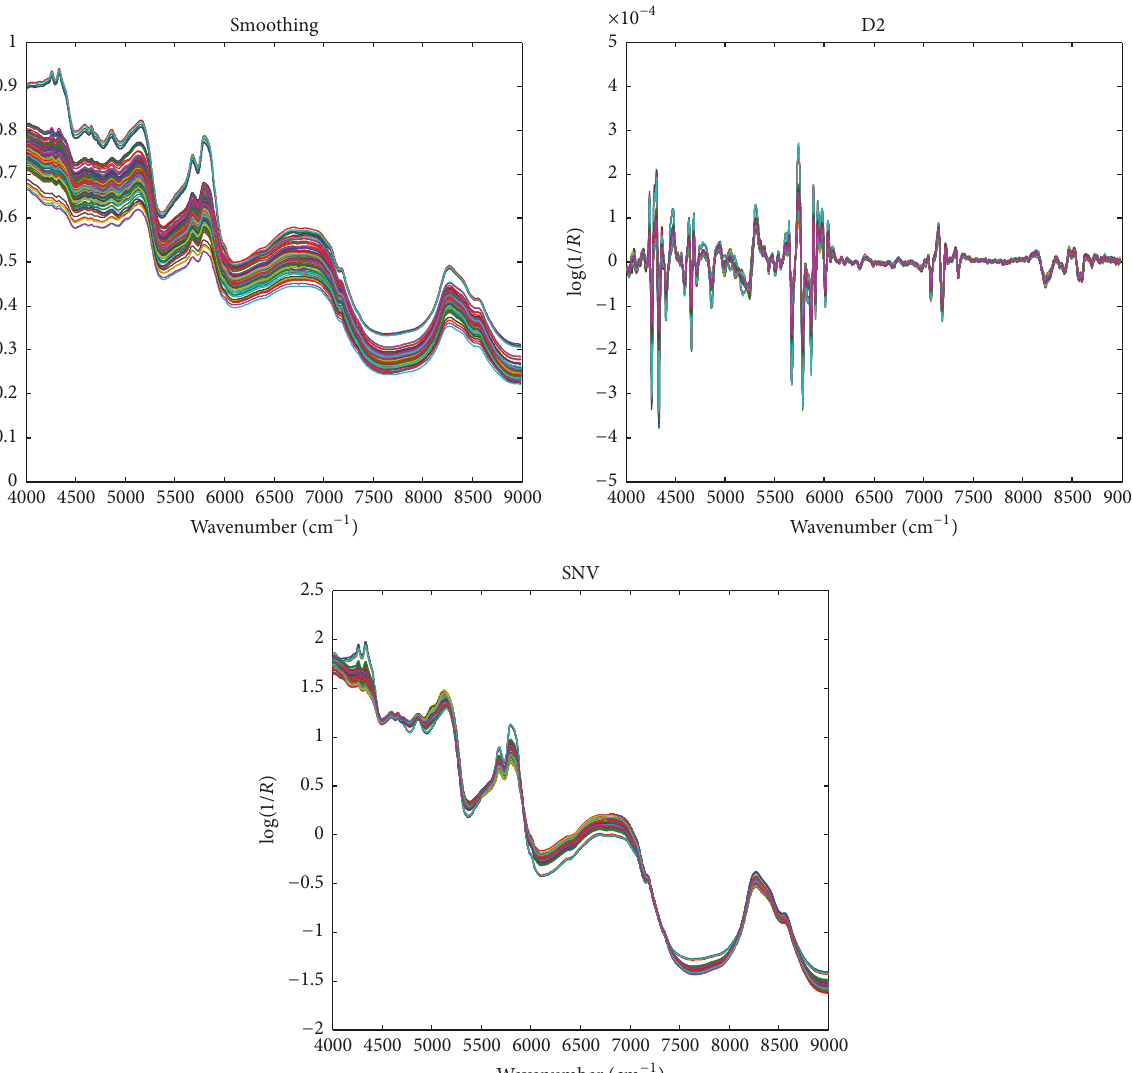
Figure 2: The preprocessed spectra of sesame seeds by smoothing, taking D2, and SNV